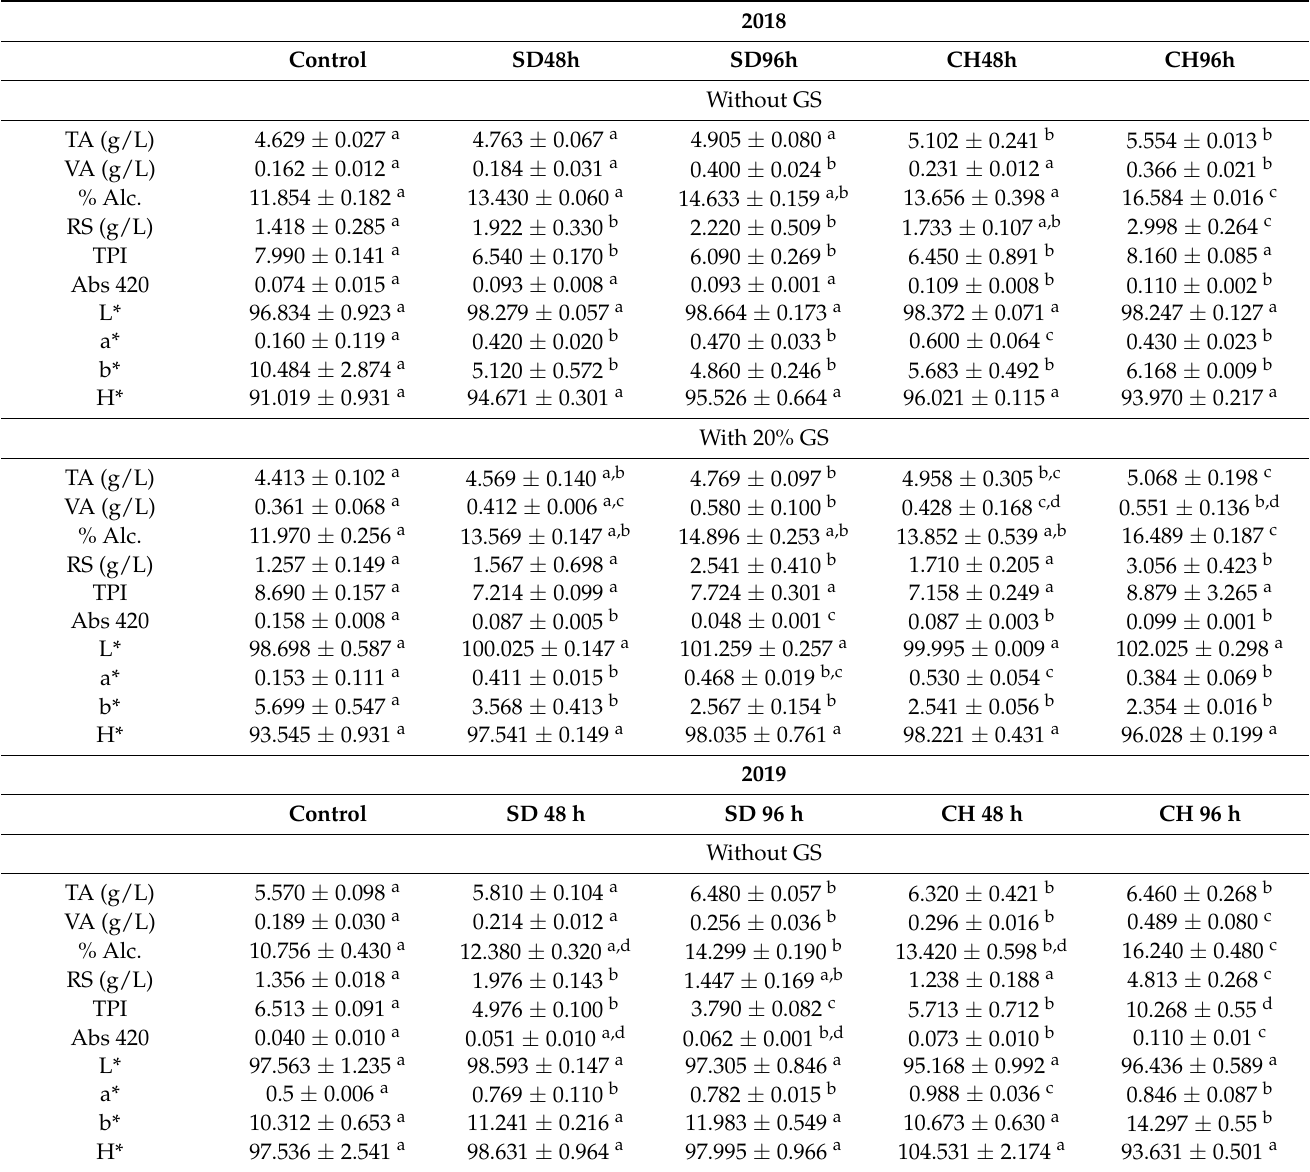
Table 2. Wine physicochemical and color